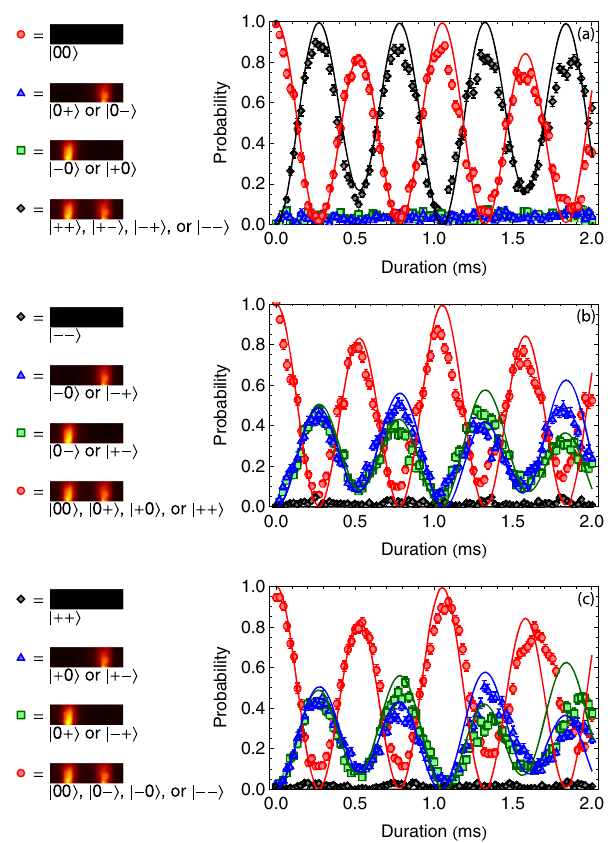
FIG. 2. Dynamics of two spin-1 particles evolving under the XY Hamiltonian in Eq. (2). (a) We measure the populations for each ion to be in the state j 0 i . The probability of both ions to be in j 0 i (black diamonds), only the left ion in j 0 i (blue triangles), only the right ion in j 0 i (green squares), and neither ion in j 0 i (red circles) are plotted together. Similar plots for the j − i state (b) and jþi state (c) are also shown, with a different symbol order emphasizing that the red circles represent the same state in all three graphs. The dynamics resemble Rabi flopping between the state j 00 i and the symmetric superposition ffiffiffi p ðj þ − i þ j − þiÞ = 2 . Solid lines represent theoretical predic- tions, with the only free parameters being the magnitude of the S z and ð S z Þ 2 gradients discussed in the text. In (c), the interaction J 1 ; 2 drifts at long times compared to that estimated from Eq. (3), consistent with an observed drift in radial trap frequencies during the data collection. Error bars (1s.d.) show the statistical uncertainty based on 500 repetitions of the